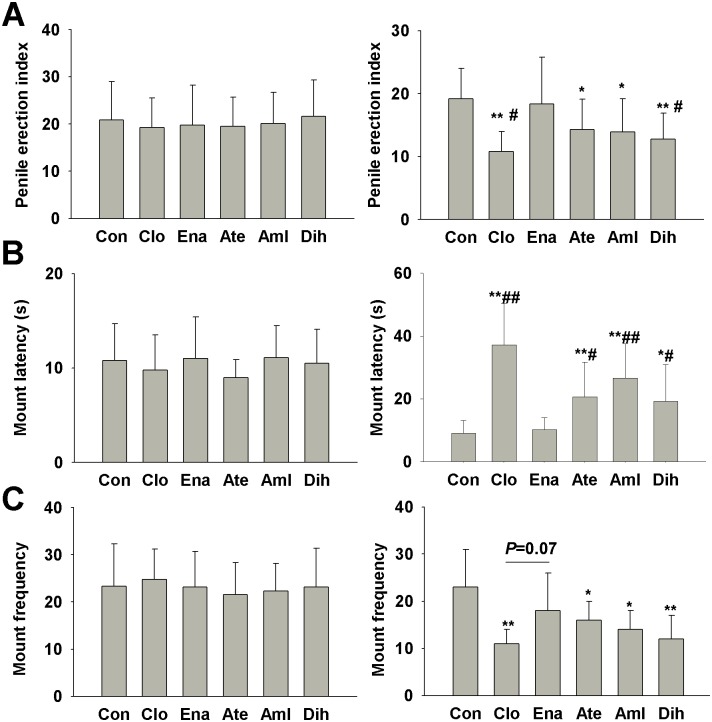
Effects of 3-month treatment of 5 different antihypertensive drugs on the penile erection and sexual behavior of male SHR.(A) Penile erection was determined for 30 min. The rat was placed in a transparent cage which was divided in half by 2 sheets. An estrus female SD rat was placed on the other side of the cage. The number of erections were recorded before (left) and after 3-month drug treatment (right). (B) and (C) Every male SHR was put in a single cage with 2 female SD rats (during non-estrus). The mount latency (B) and mount frequency (C) were recorded for 30 min before (left) and after 3-month drug treatment (right). Data are presented as mean ± SD and analyzed by ANOVA followed by LSD post-hoc testing. *P<0.05, **P<0.01 vs. control. # P<0.05, ## P<0.01 vs. Ena. SHR, n = 10, non-estrus female SD rats, n = 2. Estrus female SD rats, n = 1. Abbreviation: Clo, clonidine; Ena, enalapril; Ate, atenolol; Aml, amlodipine; Dih, dihydrochlorothiazide.